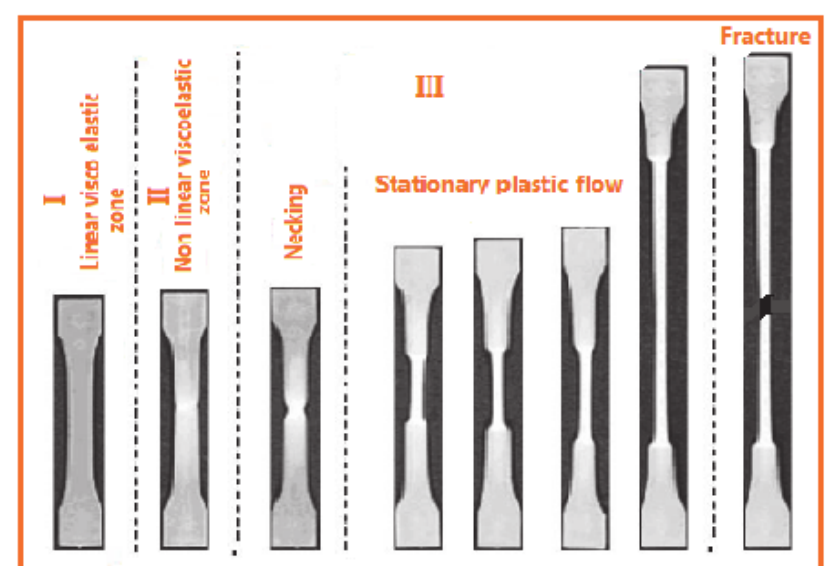
Figure 2: Different phases that the sample undergo during the tensile test.